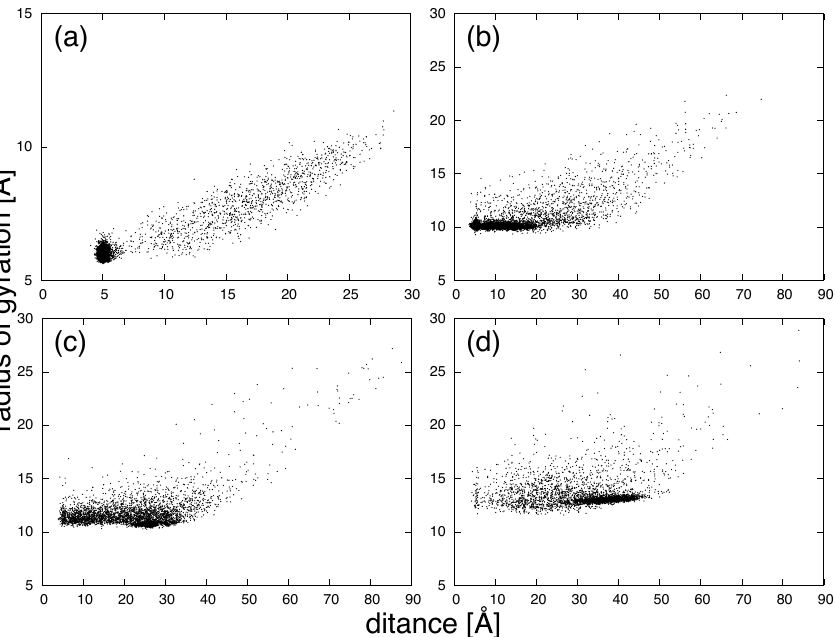
Figure 3. The radius of gyration of ( a ) CLN025, ( b ) mGTT, ( c ) mNuG2, and ( d ) m α 3D as functions of the end-to-end